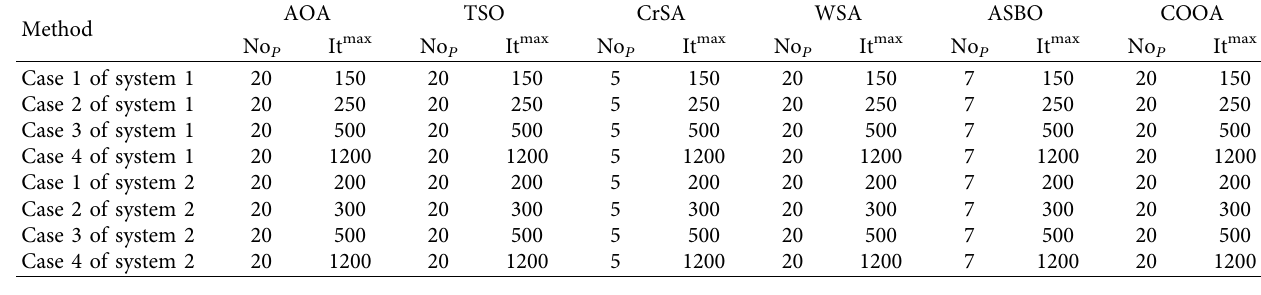
Table 2: Setting of population and iteration number for applied methods.